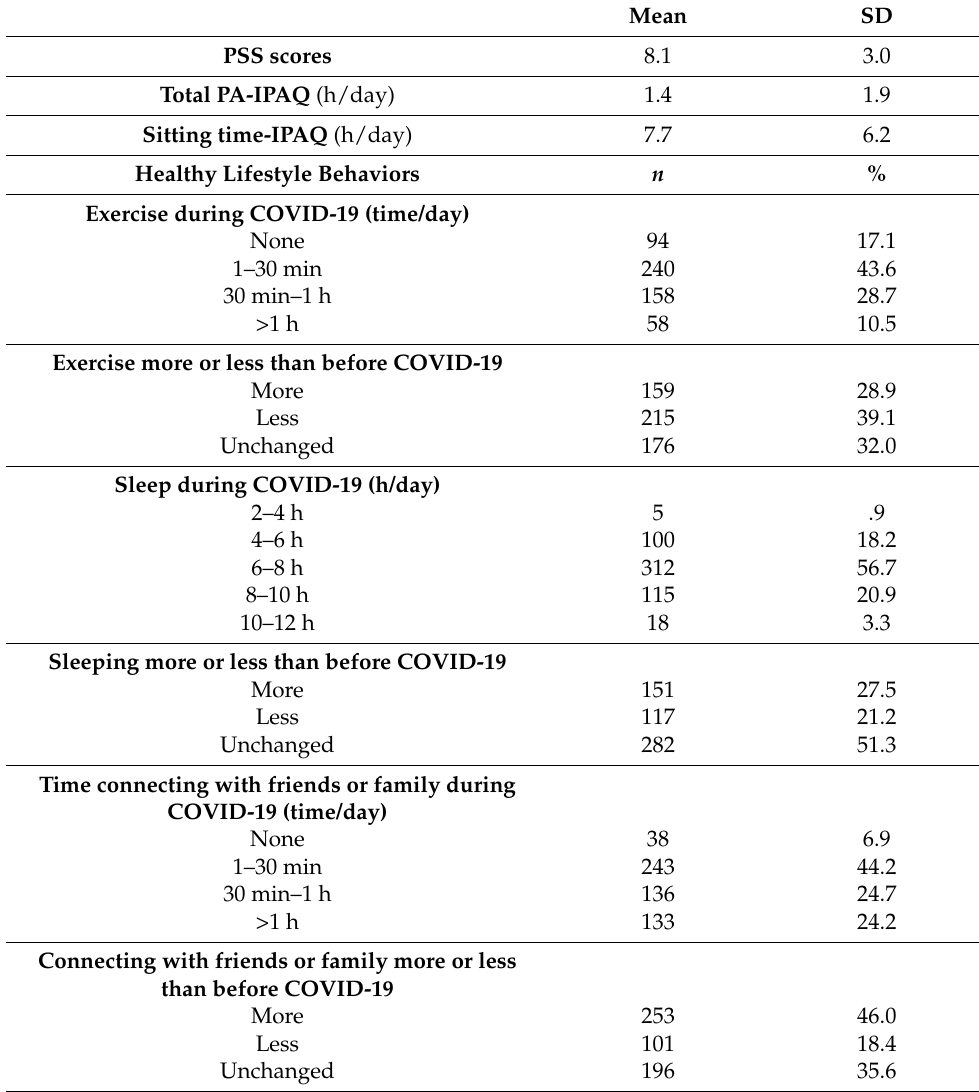
Table 2. Psychological stress and healthy lifestyle behaviors ( n = 550).